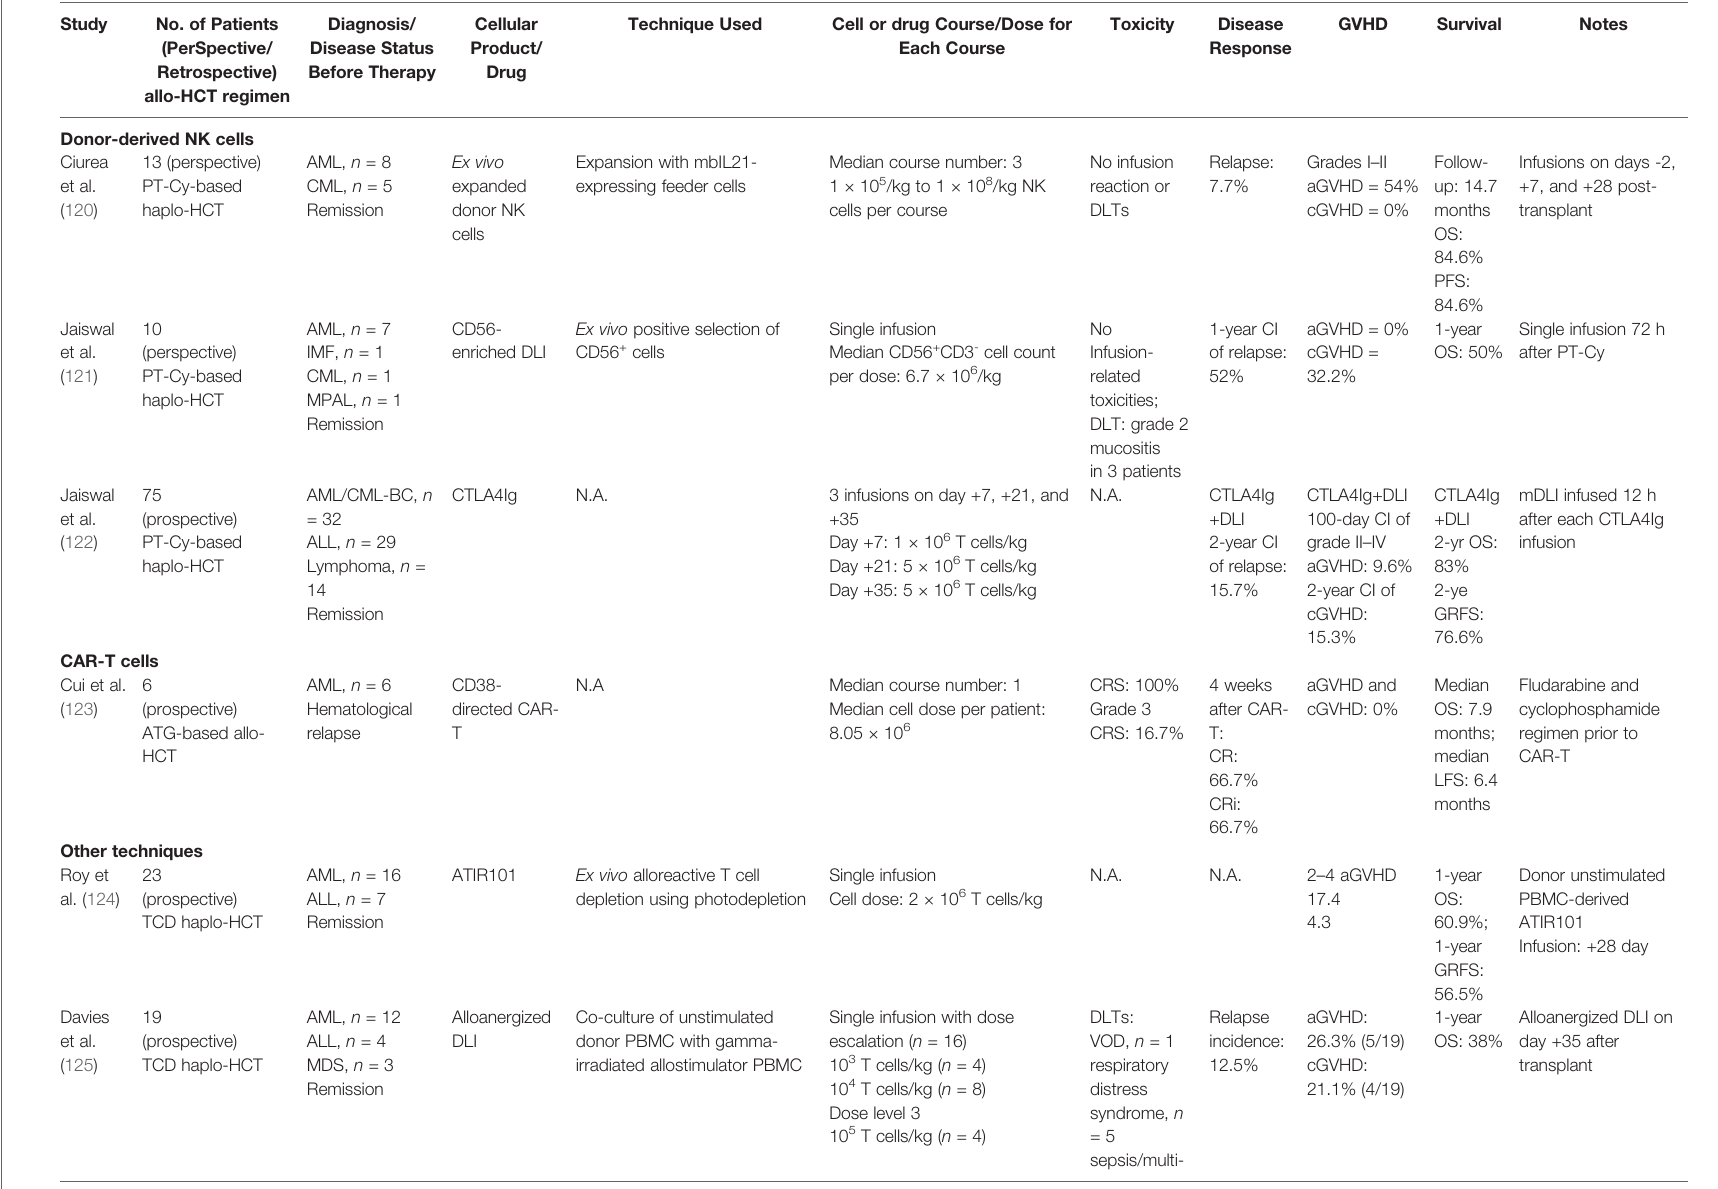
TABLE 2 | Studies on DLI composition manipulation/engineering for AML relapse after allo-HCT. Study No. of Patients